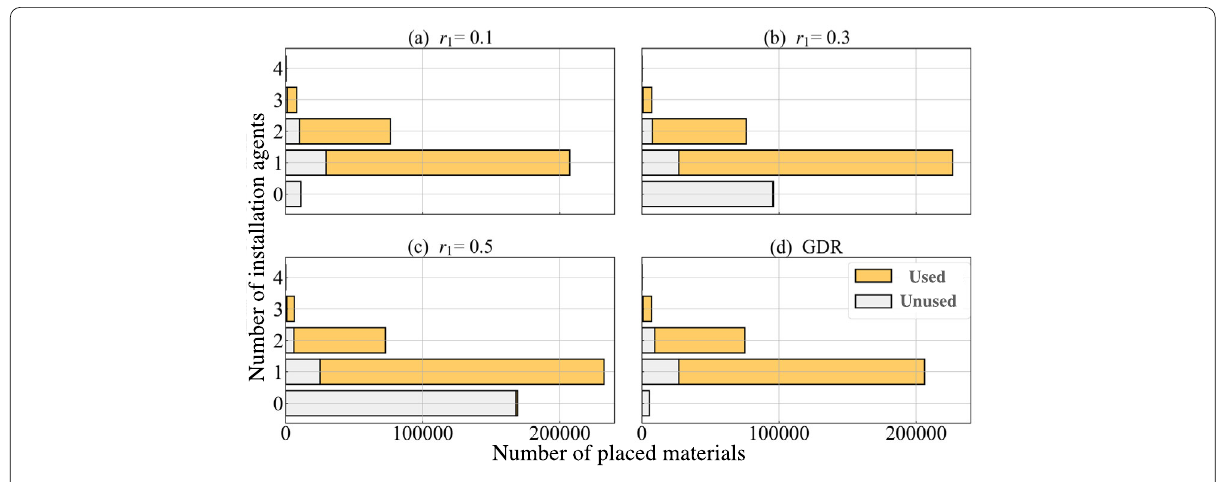
Figure 8 Number of installation agents in observable range